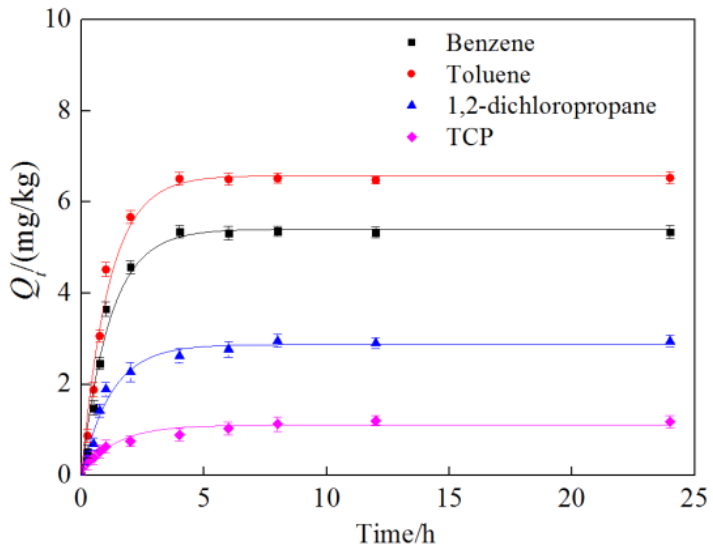
Figure 1. Adsorption kinetic curves of benzene, toluene, 1,2 − dichloropropane, and TCP on natural sand. (The initial concentration of them was 5.30, 5.45, 6.93, and 6.32 mg/L, respectively. A total of 5 g of sand was added to 25 mL of pollutant solution).